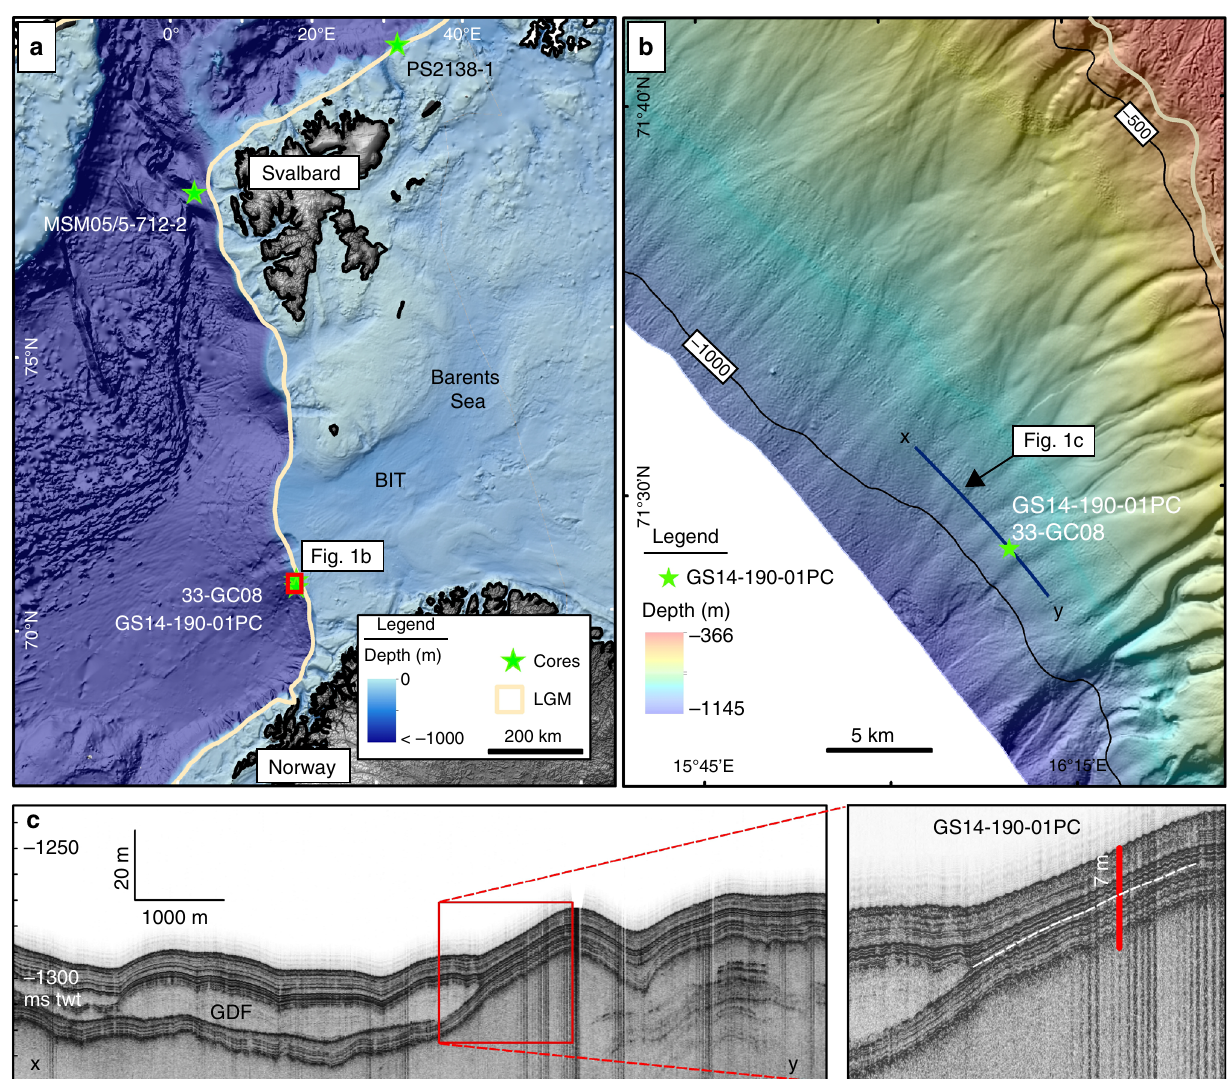
Fig. 1 Study area. a Present physiogeography with discussed sediment core locations. The outline of maximum extent of the Late Weichselian ice sheet is indicated 18 . b Site location with detailed bathymetry and shaded relief map with core positions GS14-190-01PC/33-GC08 and available seismic (TOPAS) line shown in c . Distinct morphological features of the slope are visible. Maximum ice sheet limit is shown (beige line). c High-resolution seismic data (TOPAS). Glacial Debris Flows (GDF) are interbedded with glaciomarine sediments. GDFs are characterized by acoustically uniform, transparent seismic signatures. Inset (red rectangle) shows position of piston core GS14-190-01PC penetrating the package of acoustically strati fi ed sediments. The upper 700 cm of the core penetration is marked (stippled white